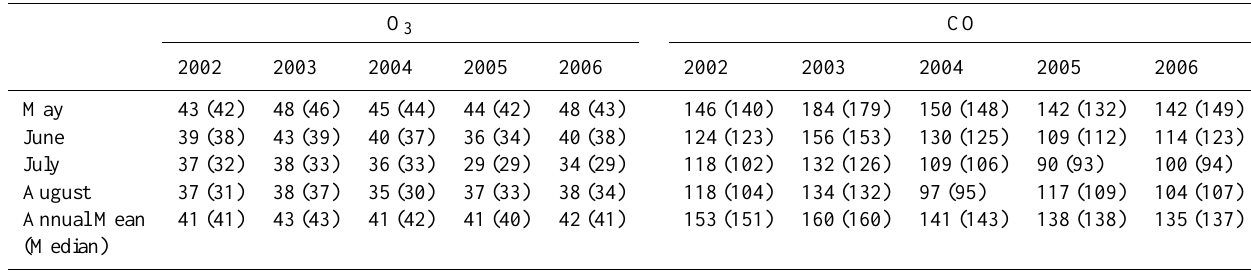
Table 2. Monthly background values defined for CO and O 3 as average mixing ratios from Box 8. The 30th percentiles of all data are also shown in